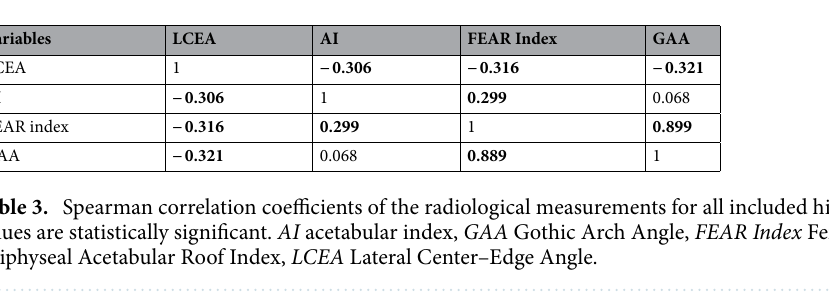
Figure 3. Bland Altmann plots for the GAA. ( A ) First measurement. ( B ) Second measurement.